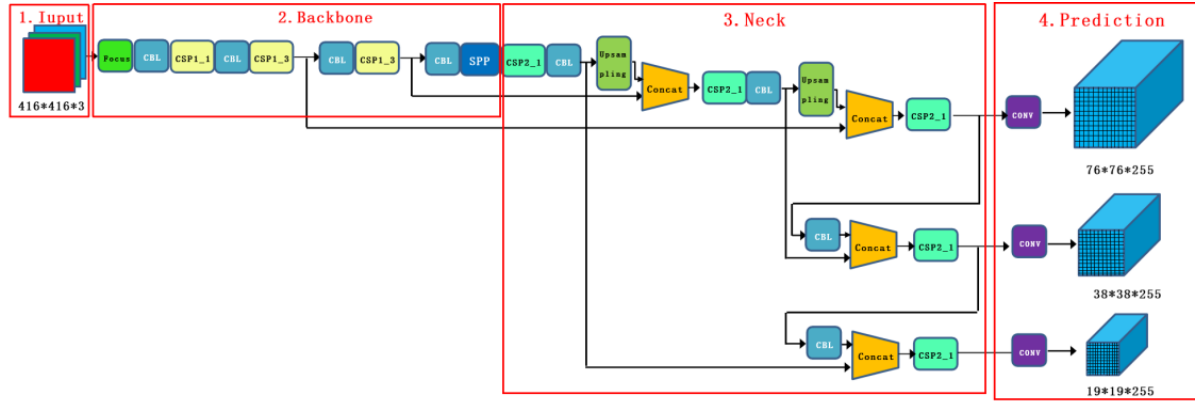
Figure 4. The main structure of the YOLOv5s model.